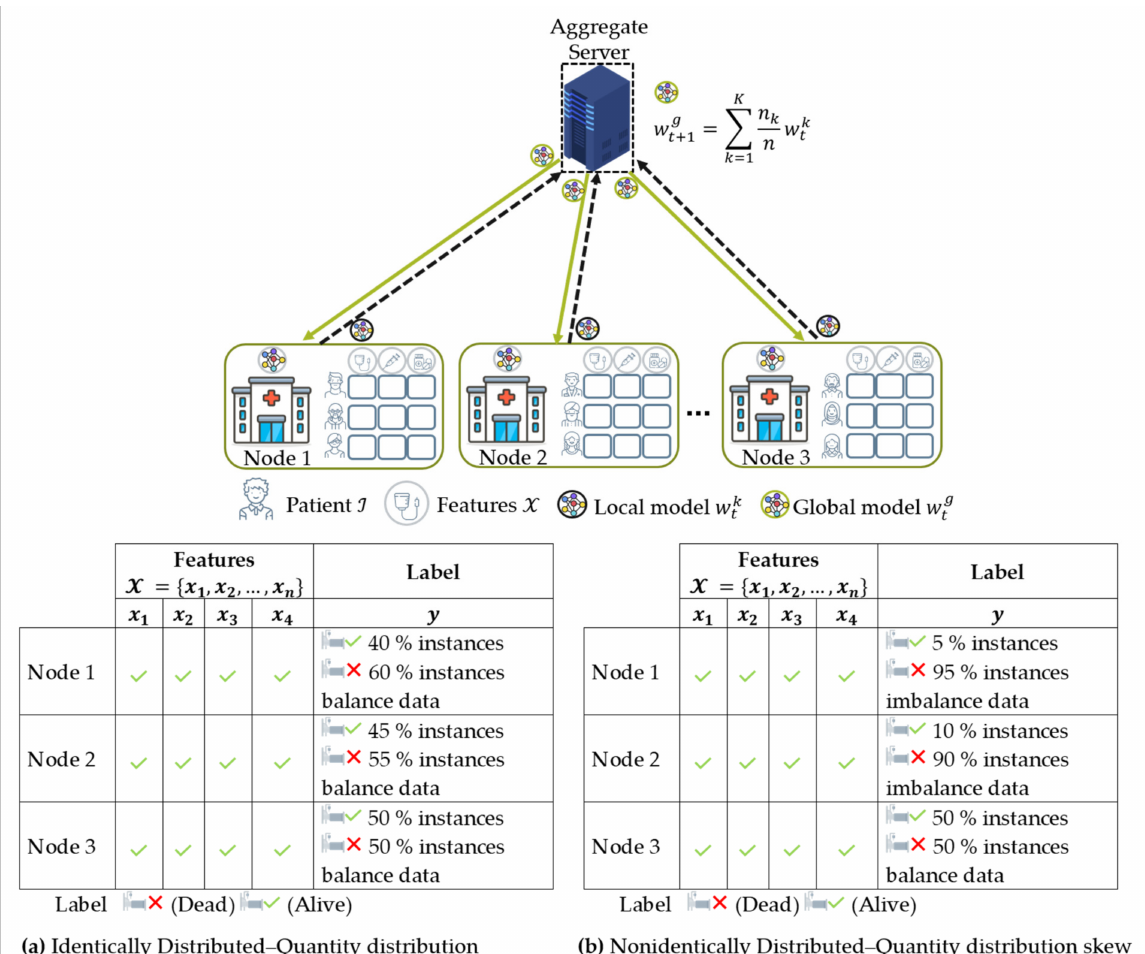
Figure 9. Non-IID from quantity skew (i.e., imbalanced dataset) characteristic. ( a ) IID: the amount ratio of positive and negative instances is equal or slightly equal; ( b ) non-IID: the ratio of positive and negative instances is far from equal. For example, the positive and negative instances ratio is 5% and 95% in node one,